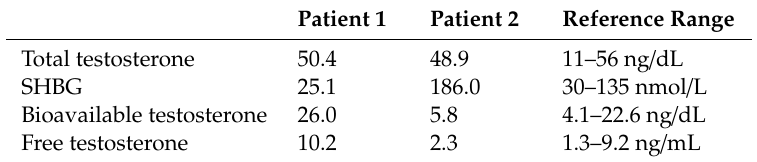
Table 1. E ff ects of sex hormone binding globulin concentration on bioavailable and free